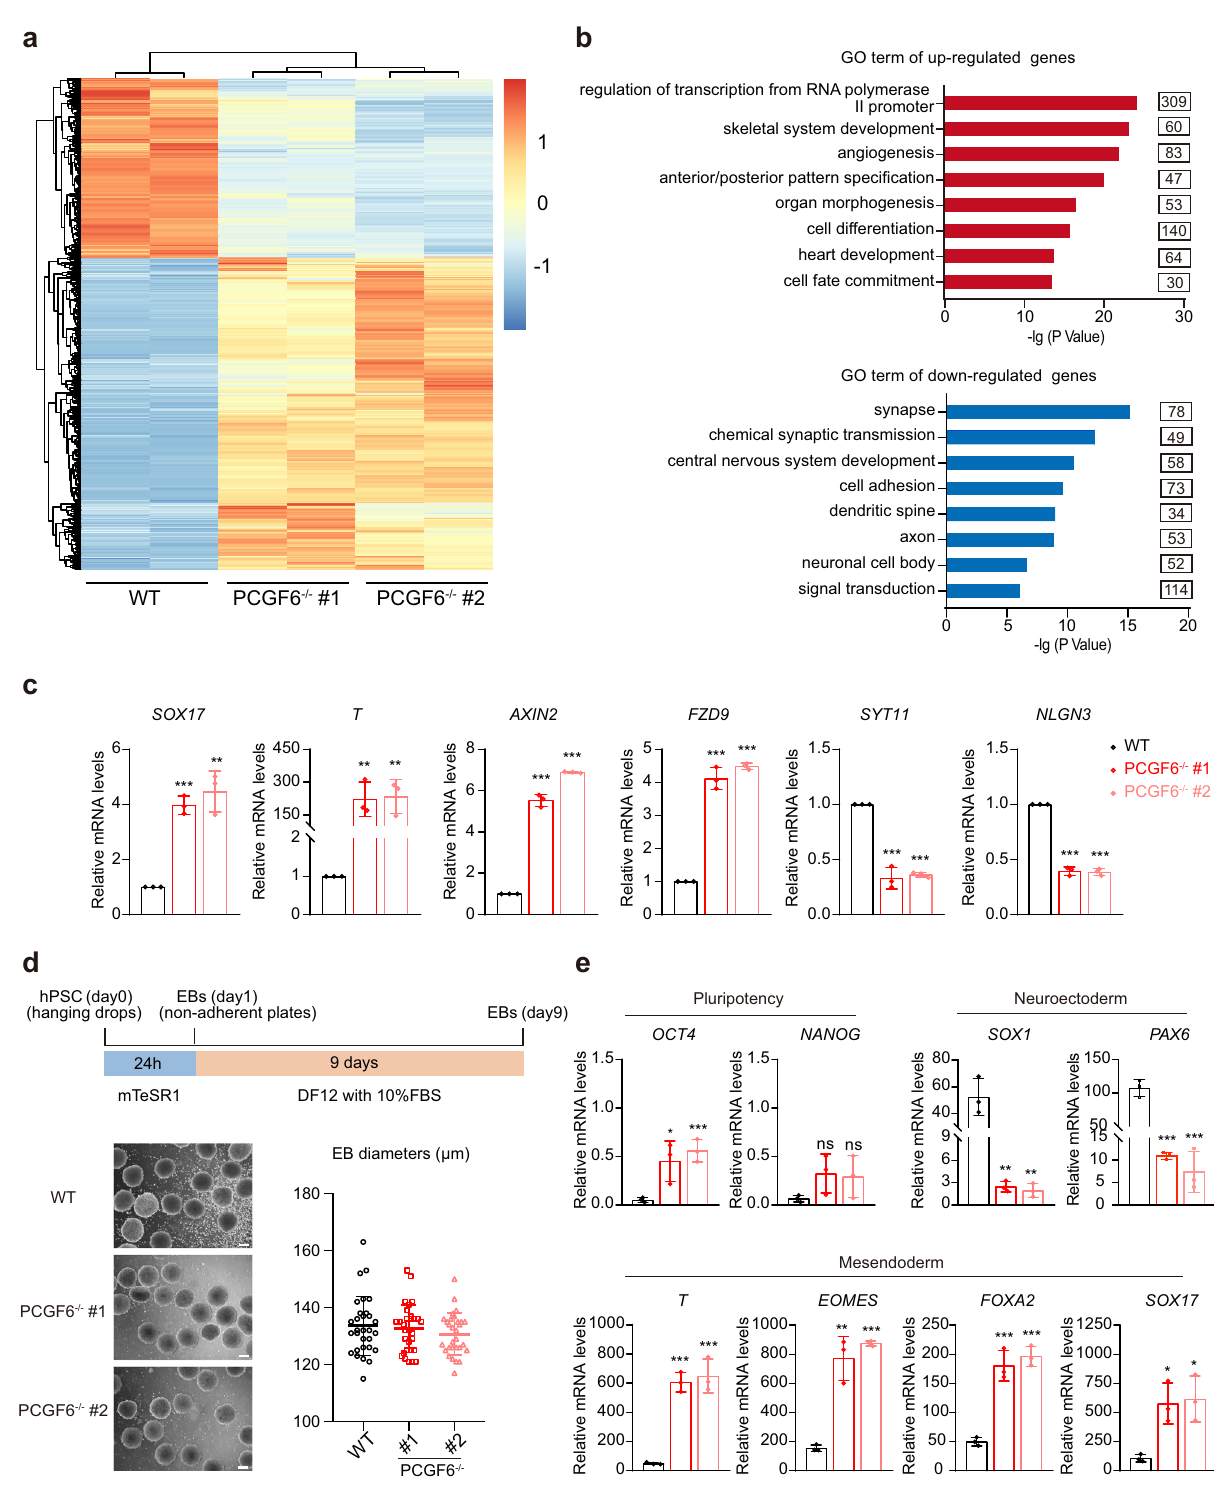
Fig. 2 | Depletion of PCGF6 results in aberrant gene expression and the imbalance of differentiation. a The heatmap showed the differentially expres- sed genes (DEGs) in WT and PCGF6-KO PSCs. b Gene Ontology analysis of upregulated (top panel) and downregulated (bottom panel) genes in response to PCGF6-knockout. c qRT-PCR was used to measure the relative mRNA expression of differentially expressed genes ( SOX17 and T for mesendoderm, AXIN2 and FZD9 for WNT signaling pathway, SYT11 and NLGN3 for neuroecto- derm)inWTandPCGF6-KOhumanPSCs.ThelevelofgeneexpressionintheWT human PSCs is set as 1 ( n =3). d Top panel: schematic representation of Embryoid body (EB) differentiation of human PSCs over 9 days. Bottom panel: